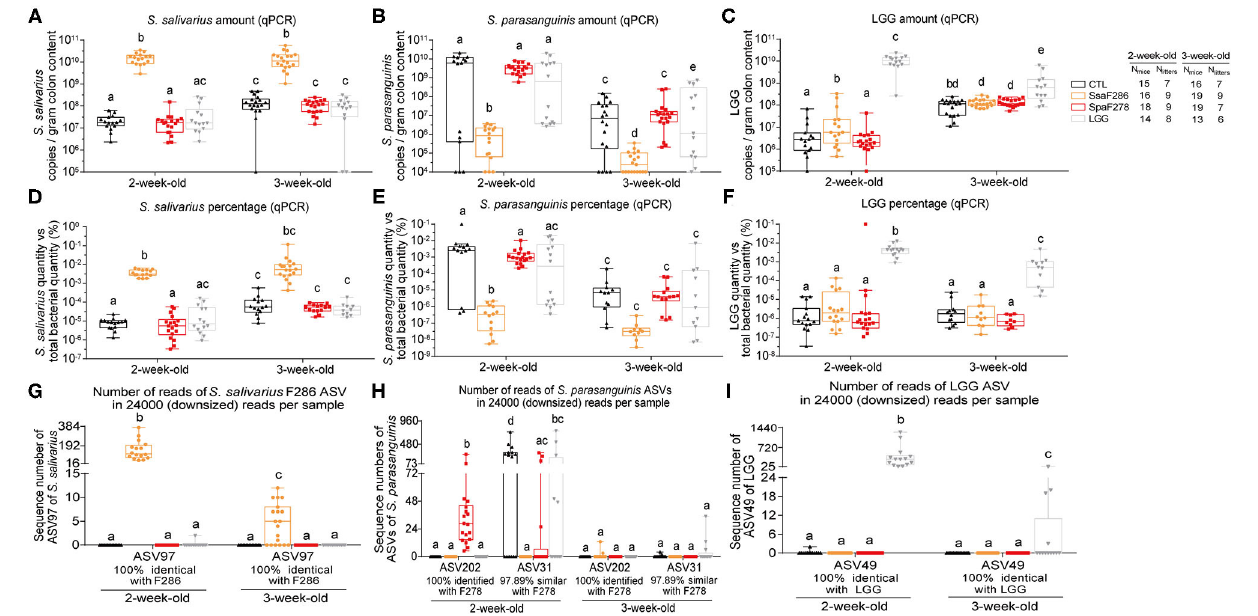
FIGURE 1 | S. salivarius F286, S. parasanguinis F278 and LGG were recovered in the colon contents of mouse pups. (A–C) The amounts of S. salivarius , S. paransanguinis and LGG determined with qPCR as the copy numbers of the targeted gene of individual bacteria per gram of colon contents of 2- and 3-week-old mouse pups. (D–F) The percentage of copy numbers of the targeted genes of S. salivarius , S. paransanguinis and LGG accounted for the total copy numbers of the 16S rRNA gene ( Supplementary Figure S1 ) in the colon contents of pups. (G–I) Sequencing read numbers of 16S rRNA gene V3-V4 region ASVs identified as S. salivarius F286, S. paransanguinis F278 and LGG in the colon contents of pups. In the box plots, the bottom and top are the 25th and 75th percentiles, respectively, and a line within the box marks the median. Whiskers above and below the box indicate the minimal and maximal values, respectively. Values of individual animal groups with different letters are considered significantly different by Mann–Whitney tests. CTL, Control group; SsaF286, S. salivarius F286 group; SpaF278, S. parasanguinis F278 group; LGG, LGG